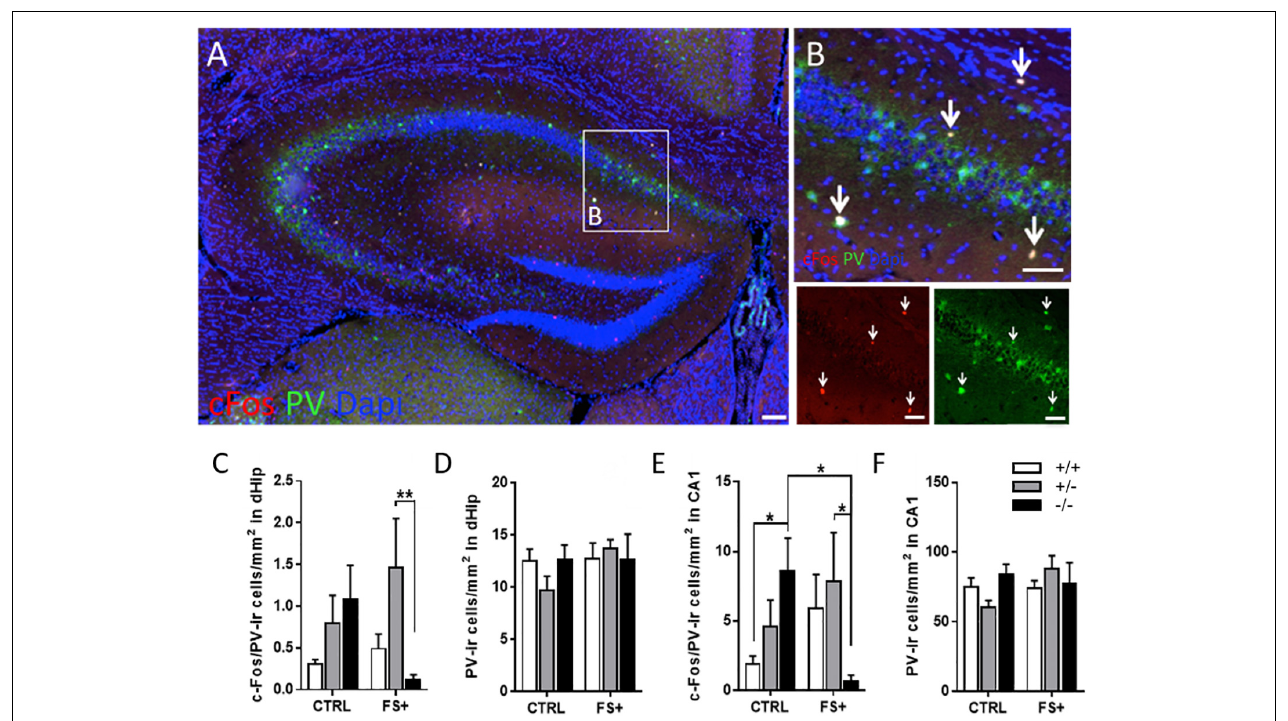
FIGURE 4 | Lifelong brain 5-HT synthesis deficiency prevents activation of parvalbumin-ir neurons in fear conditioning. (A) Anti-parvalbumin (PV) (green) and c-Fos (red) immunofluorescent staining with DAPI in the dorsal hippocampus (dHip) of a fear conditioned Tph2 + / − mouse. (B) Magnified with magnified area of cornu ammonis area 1 (CA1). Density of c-Fos/PV-ir cells of home cage control (CTRL) and fear-conditioned (FS+) Tph2 + / + , Tph2 + / − , and Tph2 − / − mice in (C) dHip and (E) CA1. PV-ir cell density of CTRL and FS+ Tph2 + / + , Tph2 + / − , and Tph2 − / − mice in (D) dHip and (F) CA1. Data are shown as means + SEM. ∗ p < 0.05; ∗∗ p < 0.01. Two-way ANOVA followed by Fisher’s LSD post hoc test. Scale bar: 100 µ